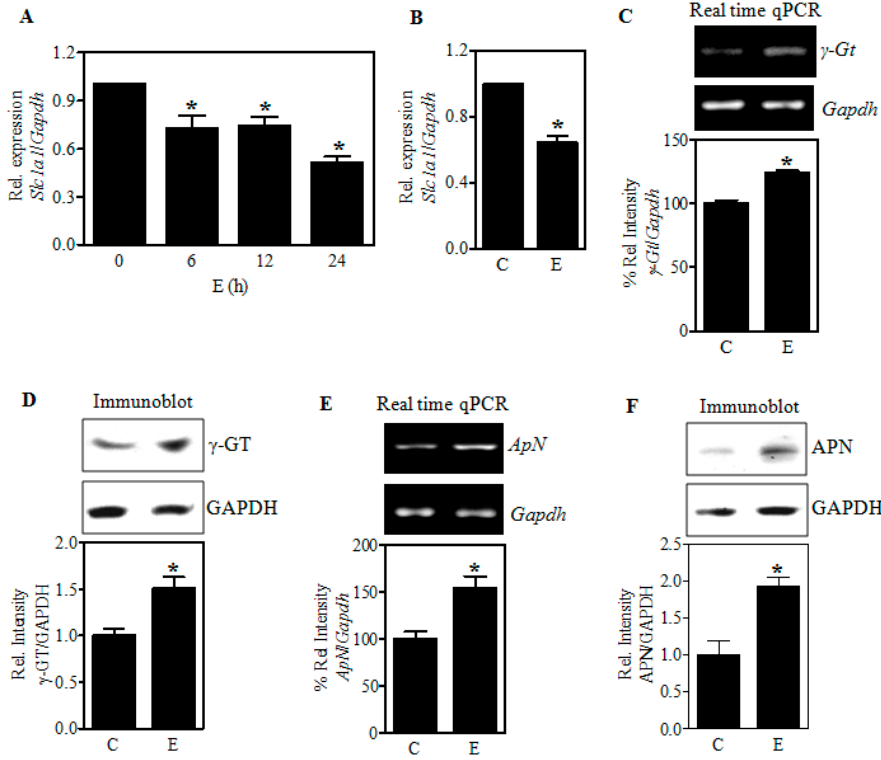
Figure 5. Effect of ethanol on the expression of EAAC1, γ -glutamyl transpeptidase ( γ -GT), and Aminopeptidase N (APN). PCNs were treated with E (4 mg/mL) for the periods indicated and real-time qRT-PCR analysis for Slc1a1/EAAC1 transcript expression was performed. The fold change expression of Slc1a1 was determined by normalizing with the expression of a housekeeping gene, Gapdh ( n = 3) ( A ); Pregnant rats (Sprague-Dawley) at embryonic day 17 were administered 5 doses of E (3.5 g/kg b.wt.) or isocaloric dextrose by gastric intubation at 12-h intervals. At embryonic day 19 brain cortex from embryos were dissected and processed for Slc1a1 and Gapdh gene expression by qRT-PCR as in panel A, ( n = 5) ( B ); Fetal brain cortices obtained as shown in Panel B was subjected to one step RT-PCR for γ -Gt ( n = 6) ( C ); and ApN mRNA ( n = 6) ( E ) expression. The top panels in C and E indicate a representative ethidium bromide staining image for γ -Gt and ApN mRNA expression respectively with Gapdh mRNA expression serving as the loading control. The bottom panels represent the percentage relative change of the respective targets normalized to Gapdh mRNA levels from control and E-treated fetal brain cortices. Protein extracts from fetal brain cortices were analyzed by Western blotting with antibodies for γ -GT ( n = 3) ( D ); and APN ( n = 3) ( F ). Top panels show a representative blot and the bottom panel shows the γ -GT and APN normalized to GAPDH protein intensity. Values represent the mean ± SEM. * p < 0.05 was considered significant for ethanol